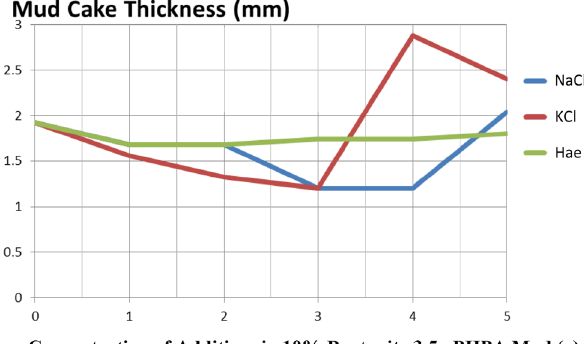
Fig. 22 Effect of KCl on yield point of PHPA–bentonite mud in accordance with time